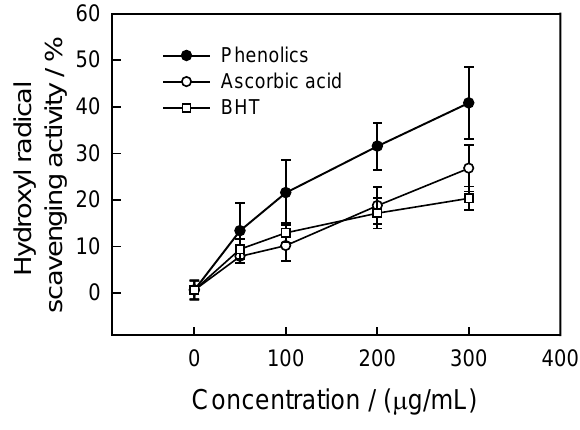
Figure 7 . Inhibitory effect of phenolics from CWC tissues on deoxyribose degradation by hydroxyl radical.